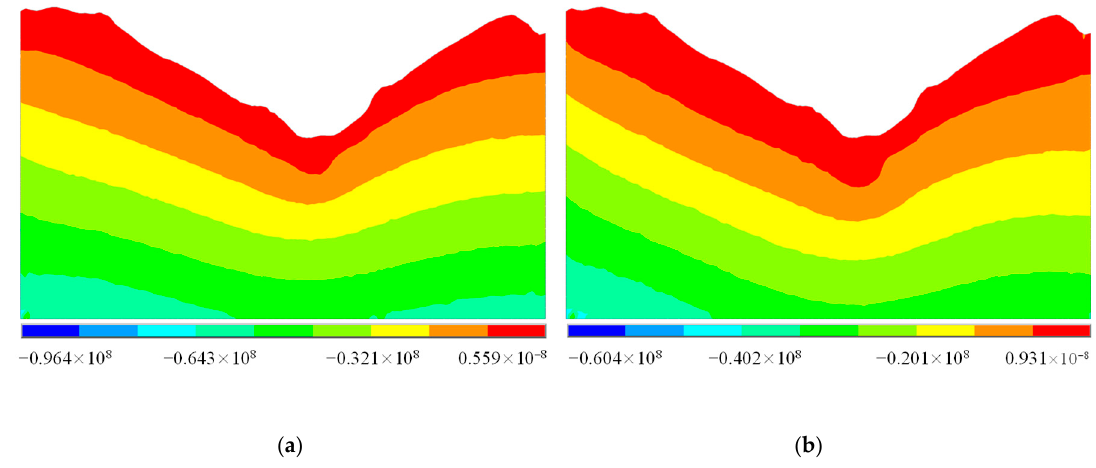
Figure 13. The vertical stress in the longitudinal section along the tunnel axis ( a ) considering geo-temperature; ( b ) without considering geo-temperature.